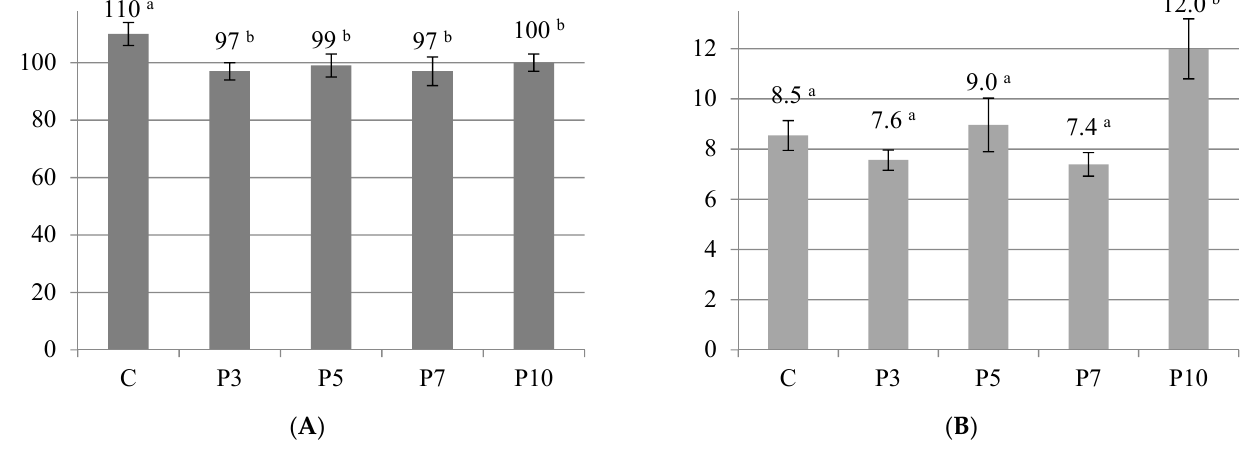
Figure 2. ( A ) Weight gain [%] and ( B ) cooking losses [%] obtained for pasta samples. C—control (semolina pasta); P3, P5, P7, P10—pasta samples with 3, 5, 7, 10 percentage replacement of semolina flour with spirulina powder. The values represent means ± standard deviation ( n = 3). The values in a row with different letters (a, b) are significantly different ( p < 0.05).